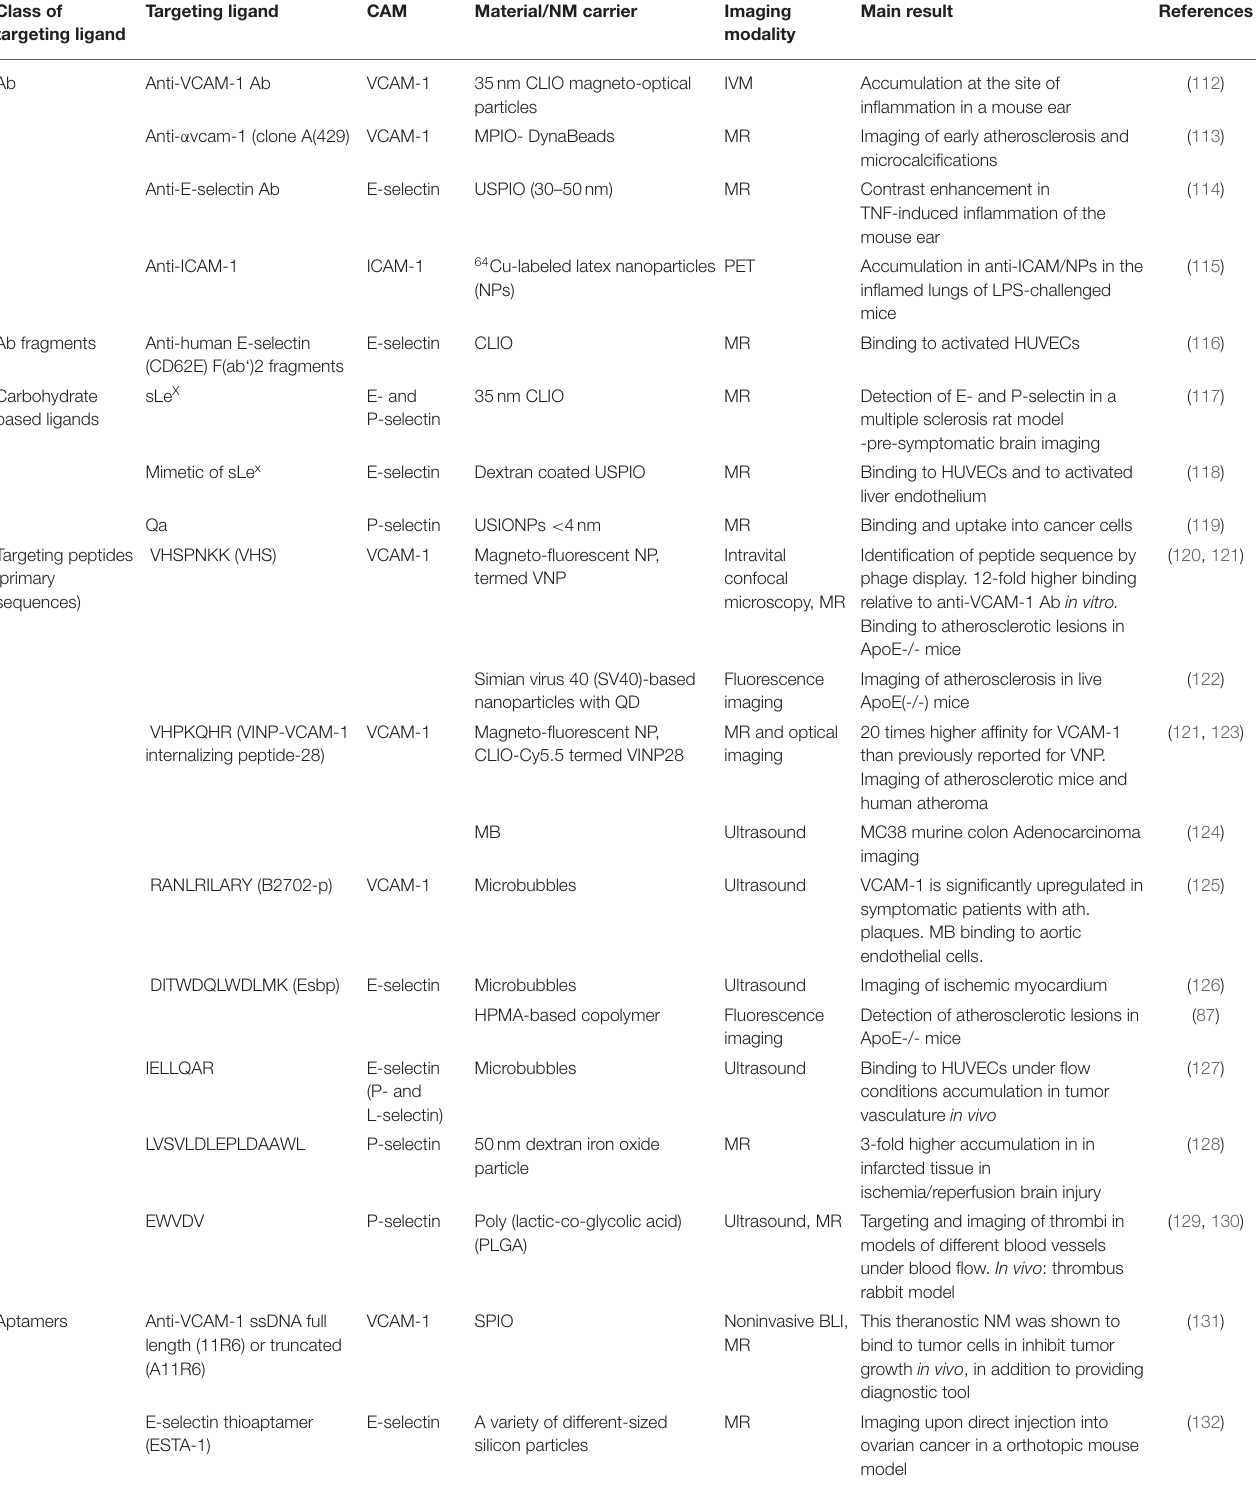
TABLE 3 | Selected examples of NM targeting CAMs for